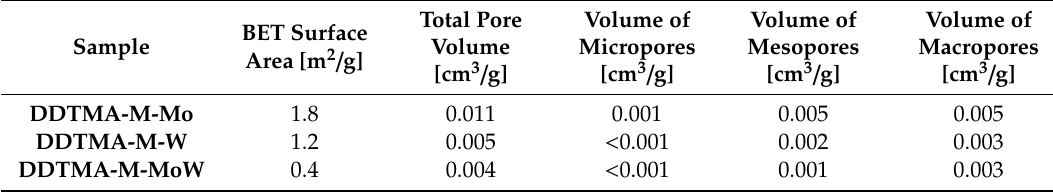
Table 3. The textural parameters of DDTMA-M-Mo, DDTMA-M-W, and DDTMA-M-MoW.